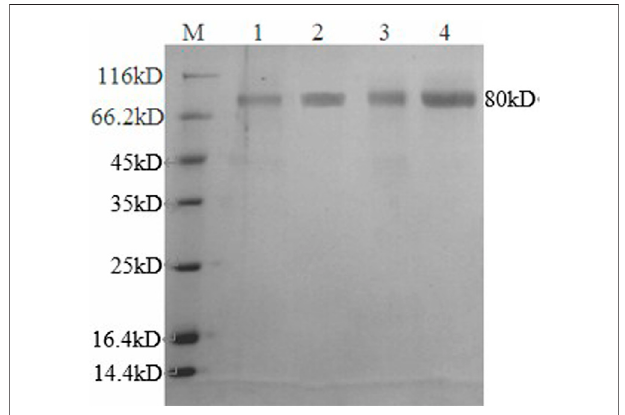
FIGURE 3 | SDS-PAGE of recombinant GAs. M: protein marker; 1: GAA1, 2: GA1; 3: GA2; 4: